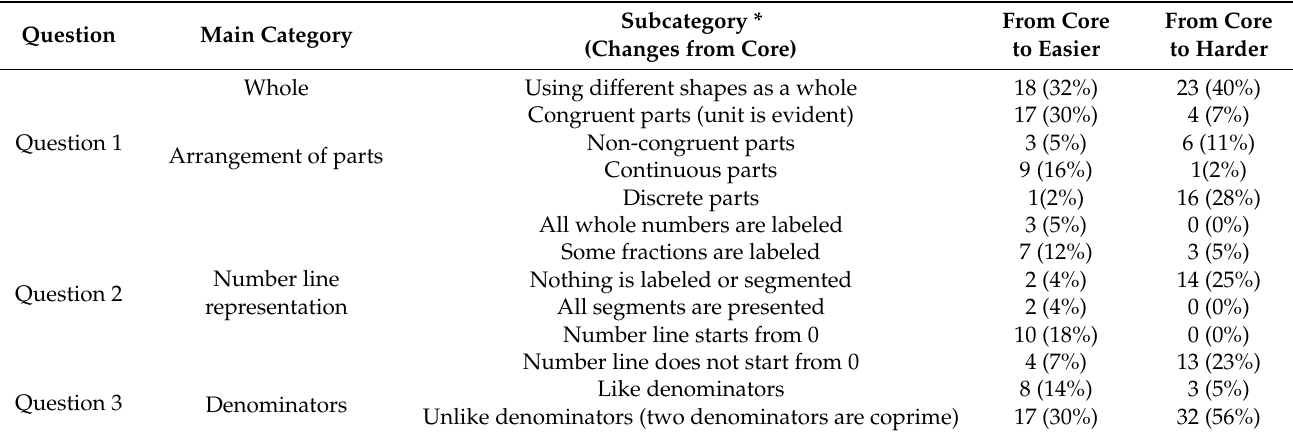
Table 6. Modification strategies in Questions 1, 2, and